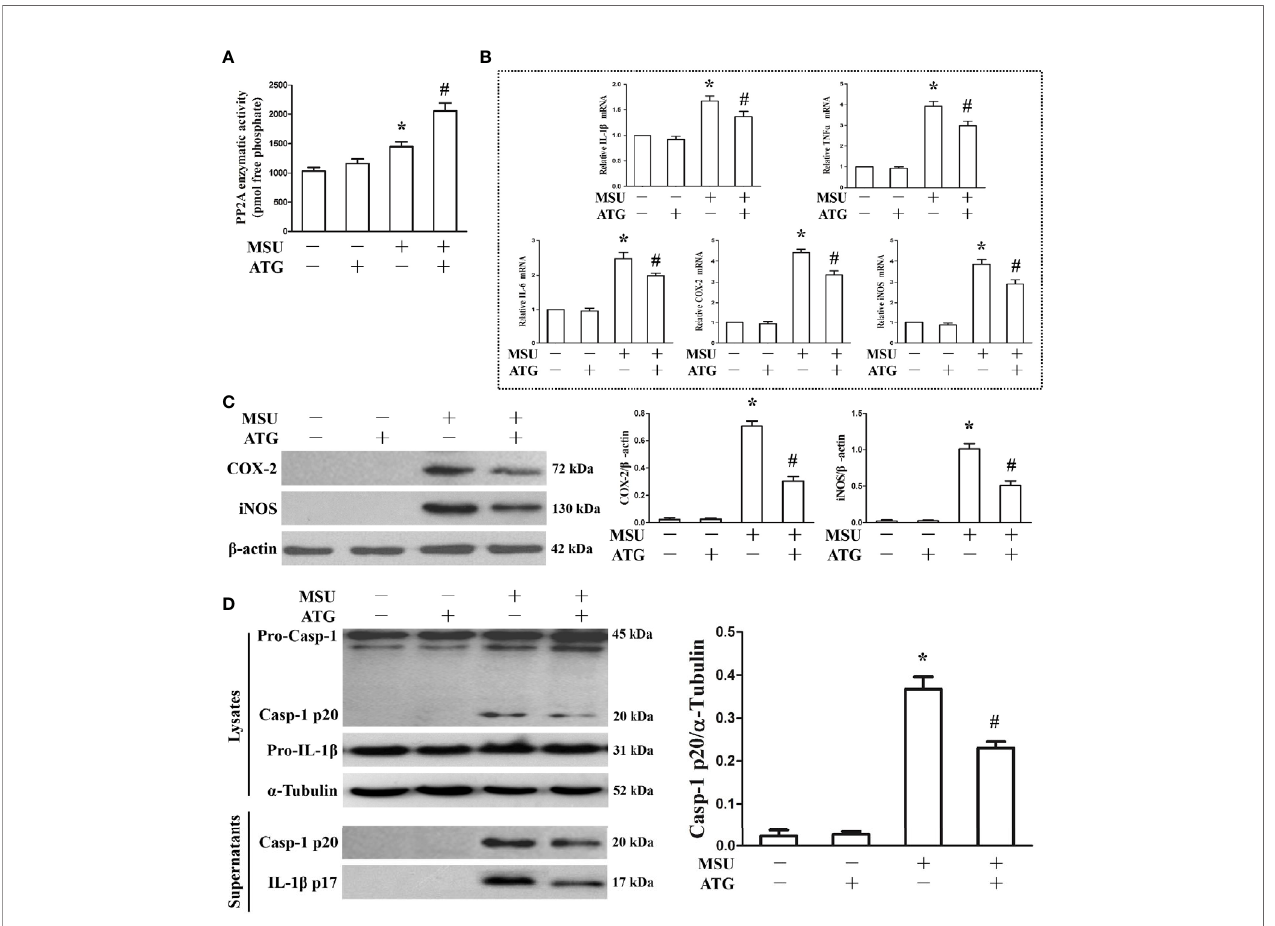
FIGURE 3 | Effects of PP2A agonist (ATG) on PP2A phosphate activity and in fl ammation-related gene expression in MSU crystals stimulated J774A.1 cells. (A – D) J774A.1 cells were pretreated with ATG (5 m M) for 1 h, primed with LPS (100 ng/ml) for 1 h and then treated with MSU crystals (50 m g/ml) for 9 h. (A) In fl uence of a PP2A agonist (ATG) on MSU crystal-induced PP2A phosphatase activity. (B) The mRNA levels of IL-1 b , TNF- a , IL-6, COX-2 and iNOS were detected using RT-PCR because of ATG treatment. (C) Western blotting was used to detect COX-2 and iNOS protein levels after ATG treatment. (D) The protein levels of the p20 subunit of Caspase-1 and IL-1 b in the cell lysates and culture supernatants were measured using Western blot. All the data are expressed as the means ± SEM from n=3 independent experiments, *P < 0.05 vs. without MSU crystals treatment; # P < 0.05 vs. MSU crystals treatment +